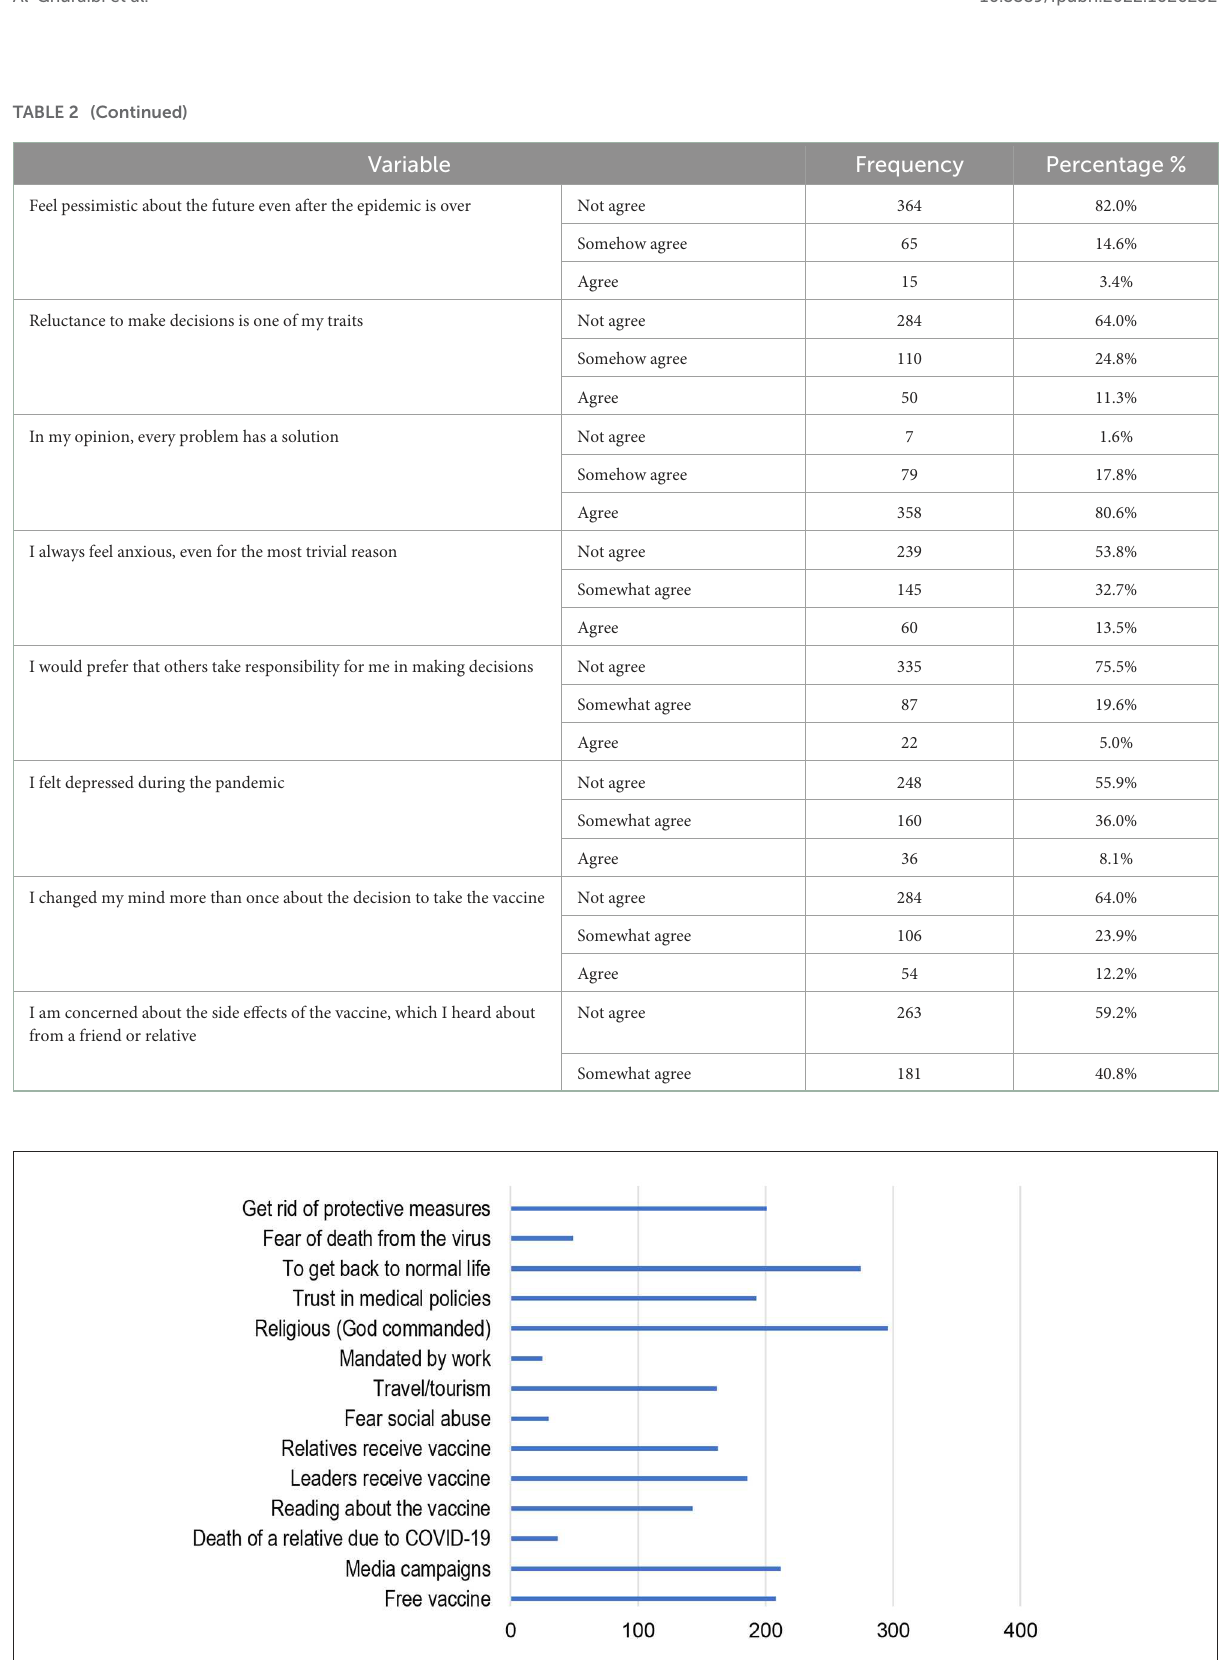
FIGURE1 Social and cultural motivations behind individuals’ decisions to take the